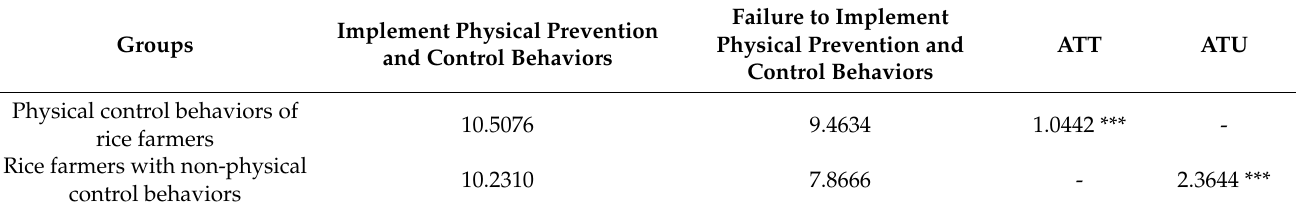
Table 10. Average treatment effect of rice farmers’ physical control behaviors choice on rice income and output.